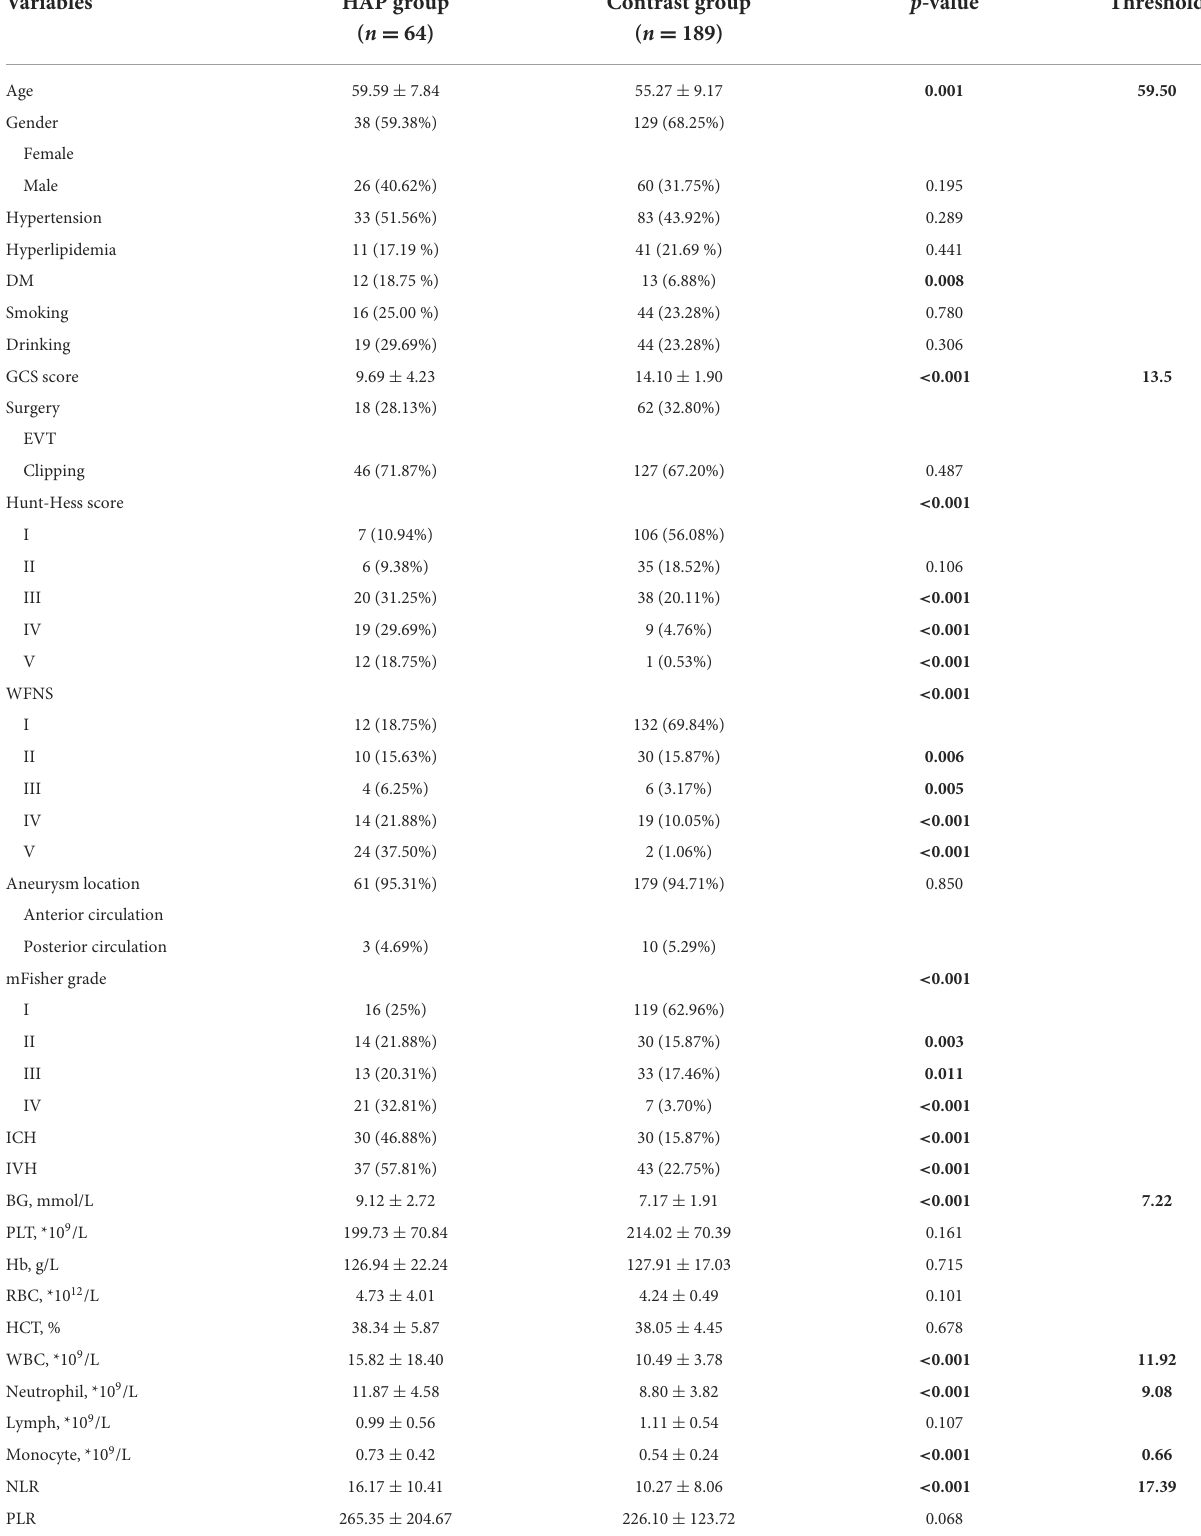
TABLE 1 Clinical characteristics and univariate analysis of the